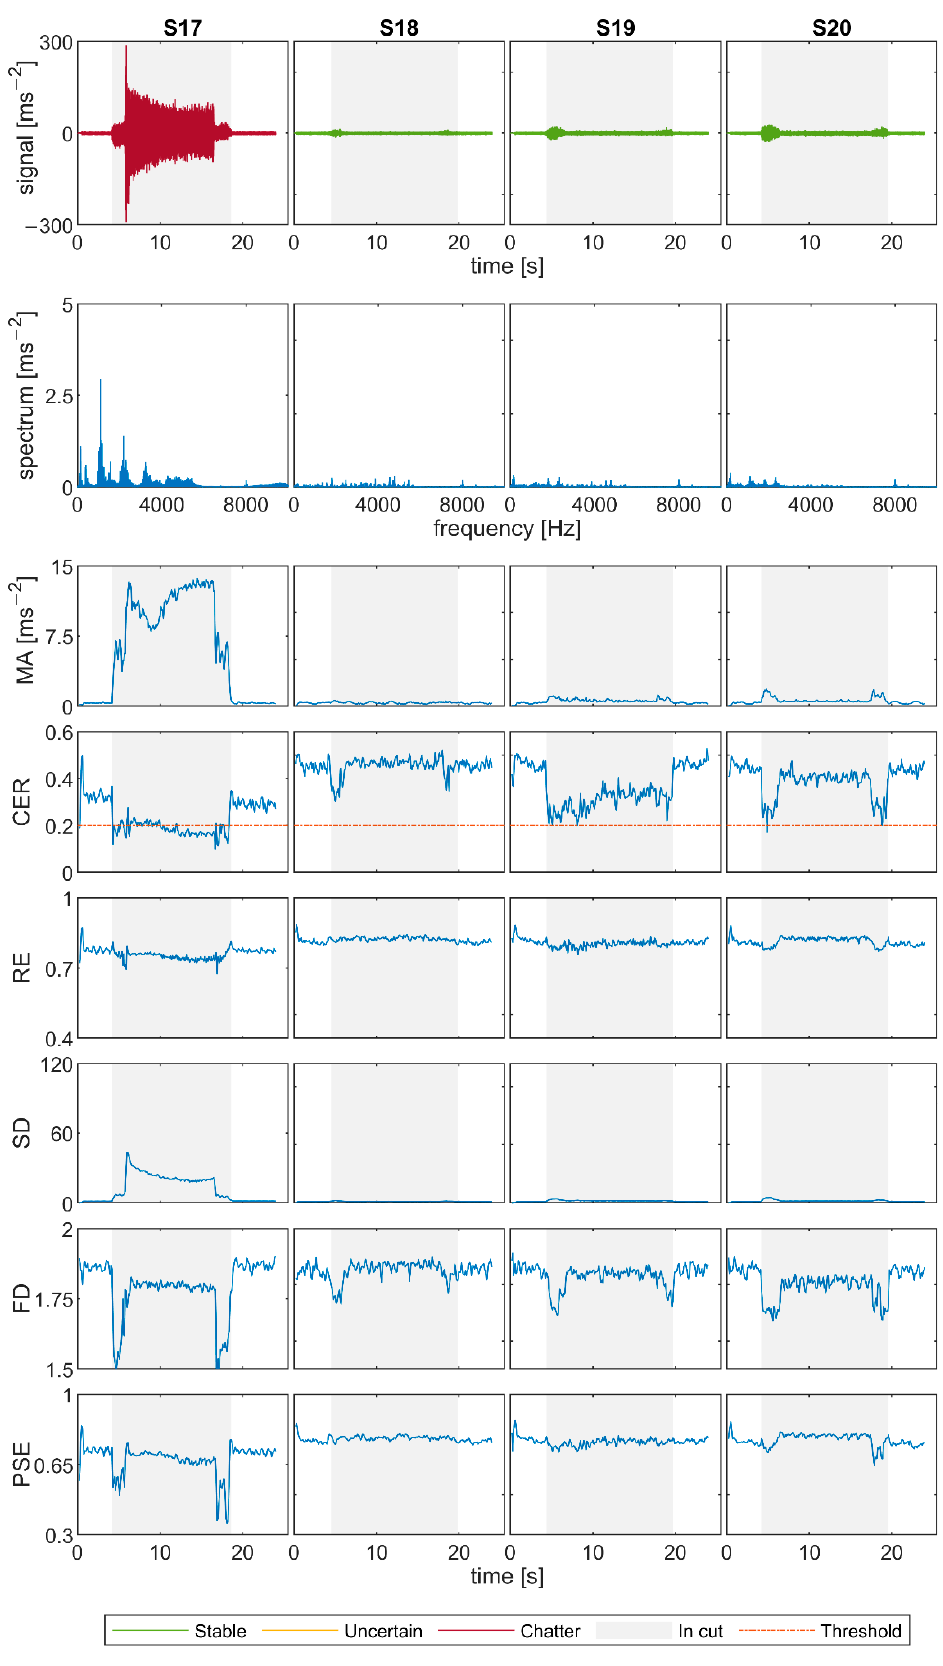
Figure A4. Signals from Experiment 3—shoulder mill.